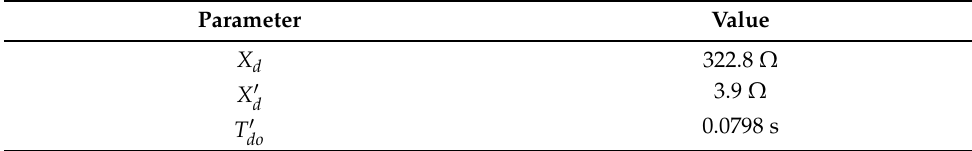
Figure 5. Top row: Measurement (solid line) and fitted function (dashed red line) of the load rejection test where the same test has been repeated twice. Bottom row: Measurement (solid line) and fitted function (dashed red line) of the voltage recovery test where the same test has been repeated twice. Table 3. Estimated electrical parameters d